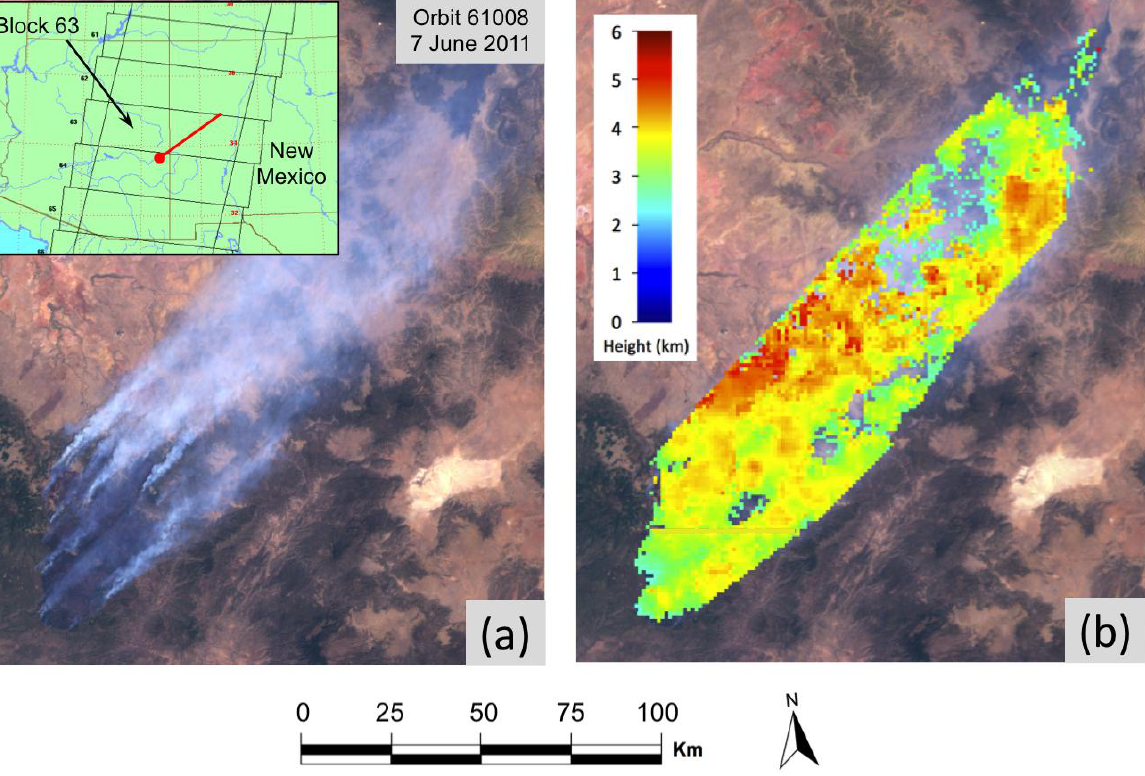
Figure 15. The Wallow fire in Arizona on 7 June 2011, on MISR orbit 61008, blocks 62–64: ( a ) Nadir image of multiple smoke plumes from hot spots around dark burn scars; ( b ) wind-corrected heights retrieved using the new blue-band and extra-large matcher template options in version 2.0 of MINX. Smoke reached a height of more than 5 km above-sea-level. Terrain heights in this region are about 2.5